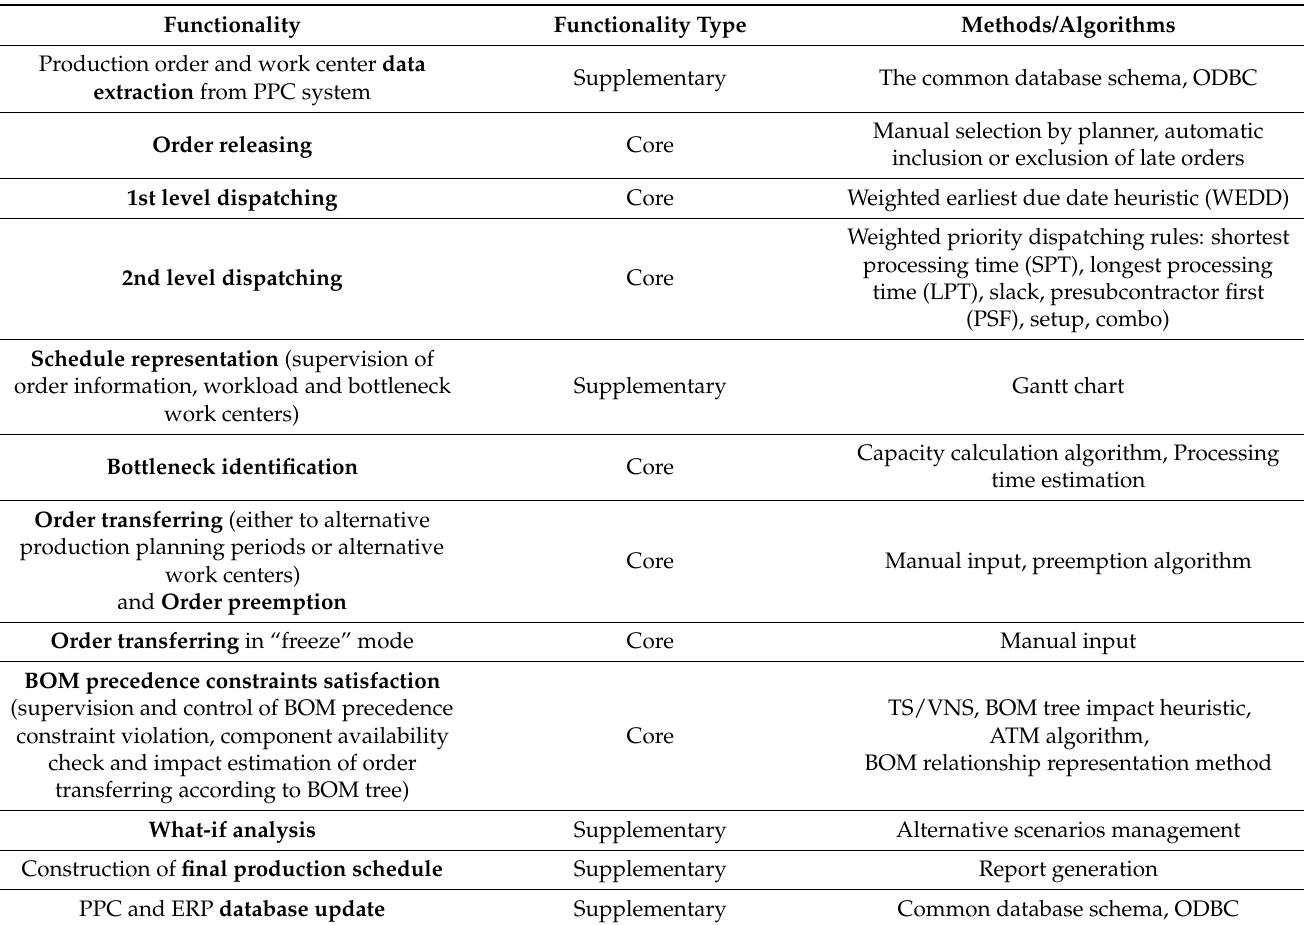
Table 3. G-DSS’s functionality and